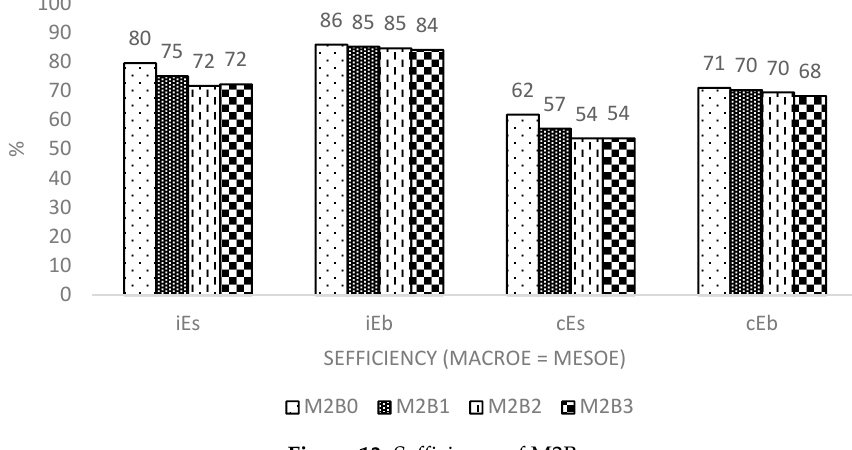
Figure 13. Sefficiency of M2B.